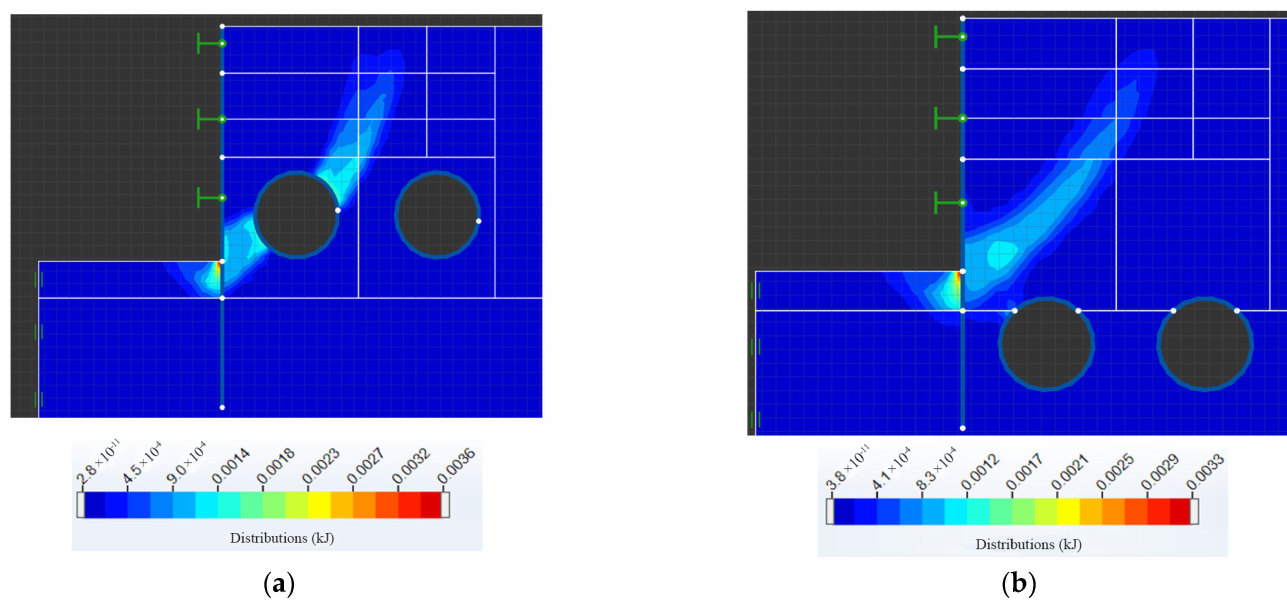
Figure 22. Shear dissipation contours under different cover depth C of the twin shield tunnels in stage (4): ( a ) C = 0.5 H and ( b ) C = 1.0 H.